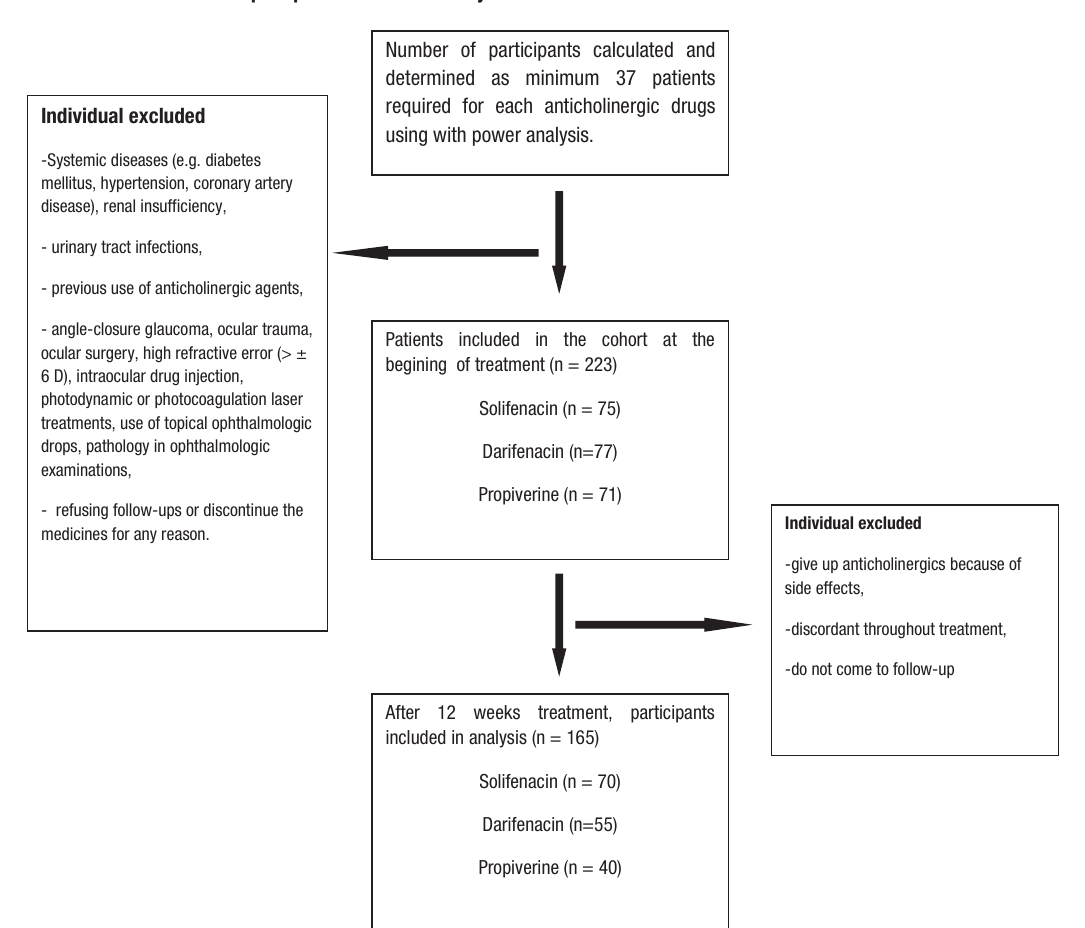
Figure 1 - Flow-chart of the our prospective cohort